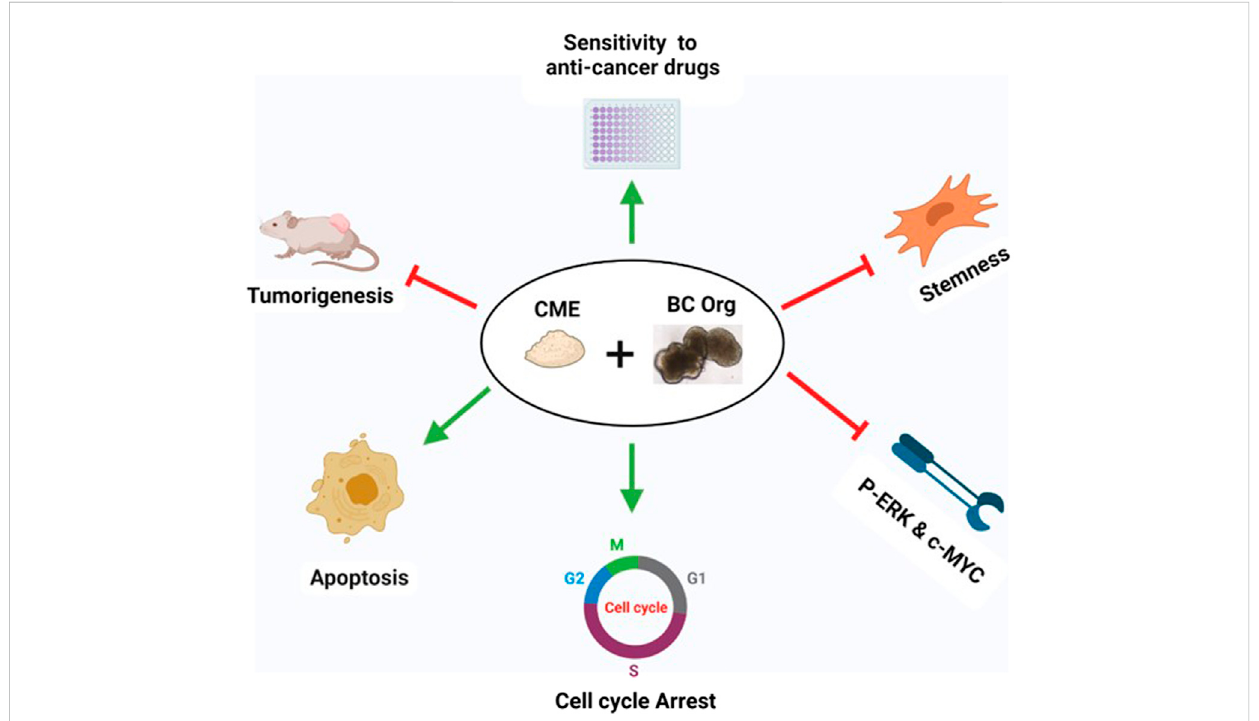
FIGURE 9 Summary of the effects of Chaga on DBCO. Chaga suppressed the survival of organoids by arresting the cell cycle, inducing apoptosis, targeting stemness, and decreasing the phosphorylation of ERK and expression of its downstream signal molecule, C-MYC, and Cyclins. Chaga also enhanced the action of the commonly prescribed anti-cancer drugs for BC. Further, the effect of Chaga has been veri fi ed in vivo